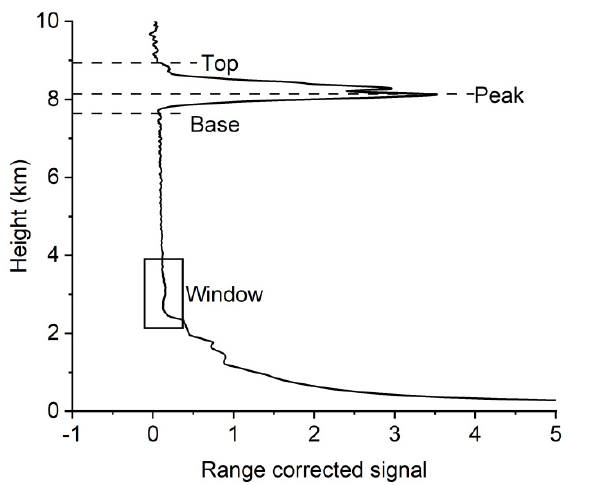
Figure 3. A case of cloud detection using the cloud discrimination algorithm and the observation lidar data at 19:30 (UTC) on 10 September 2005.